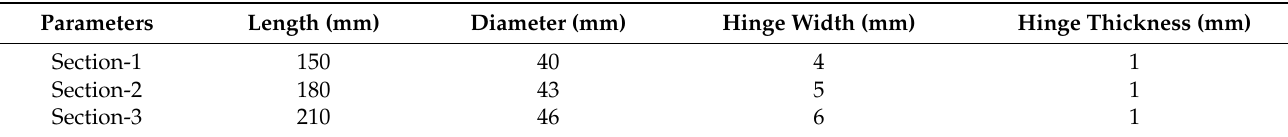
Table 1. Structure parameters of the continuum robot.